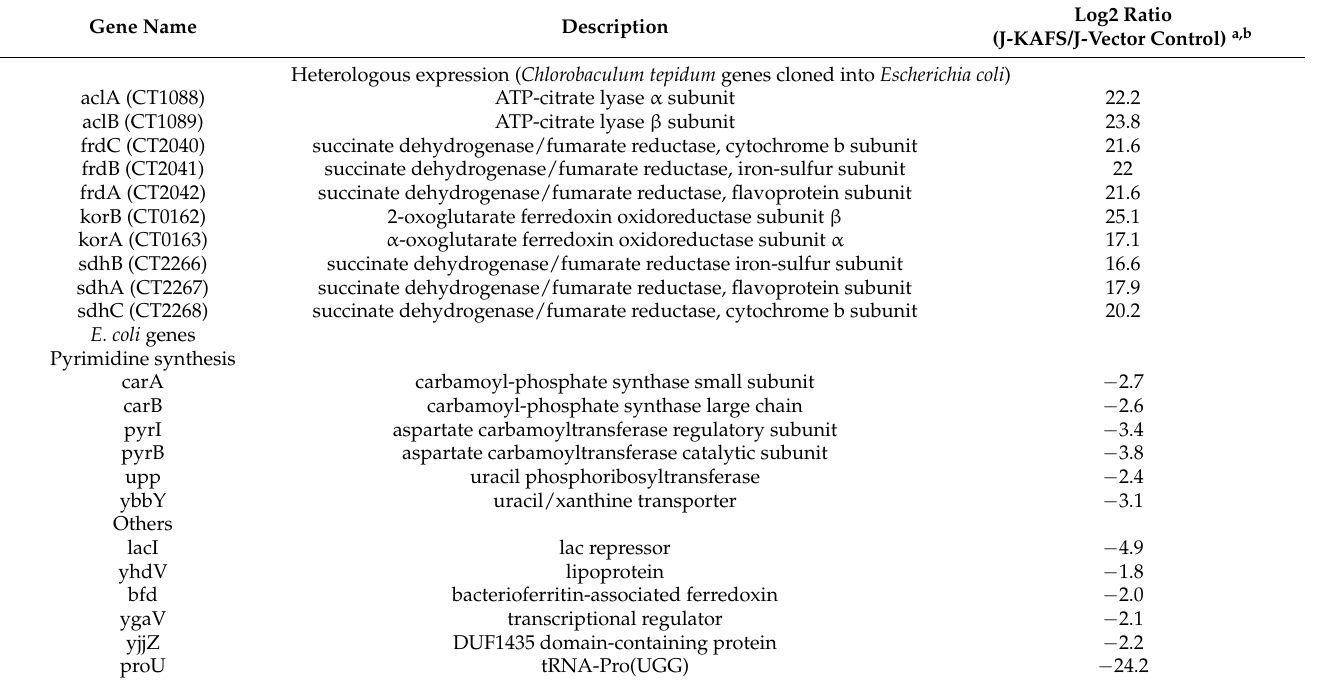
Table 2. Differential gene expression of E. coli J-KAFS and J-vector control strains incubated with glucose and CO 2 gas for 12